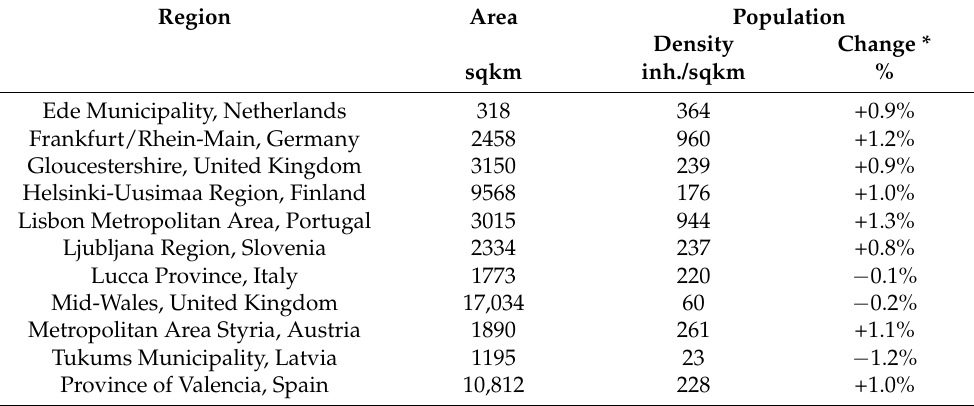
Table 2. Brief characterization of the 11 regions examined in this